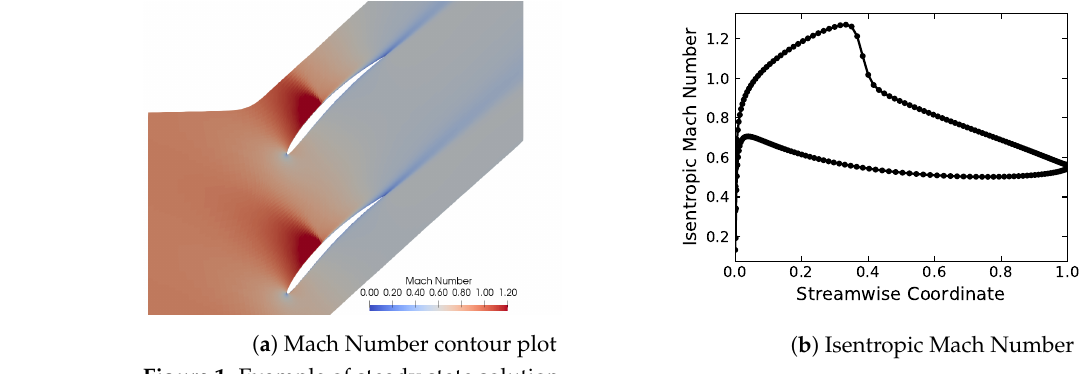
Figure 1. Example of steady state